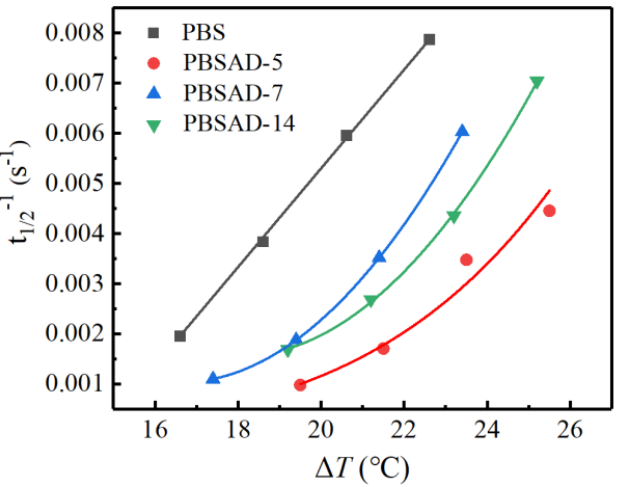
Figure 5. The plots of total crystallization rates versus supercooling degrees of PBS and PBSAD.